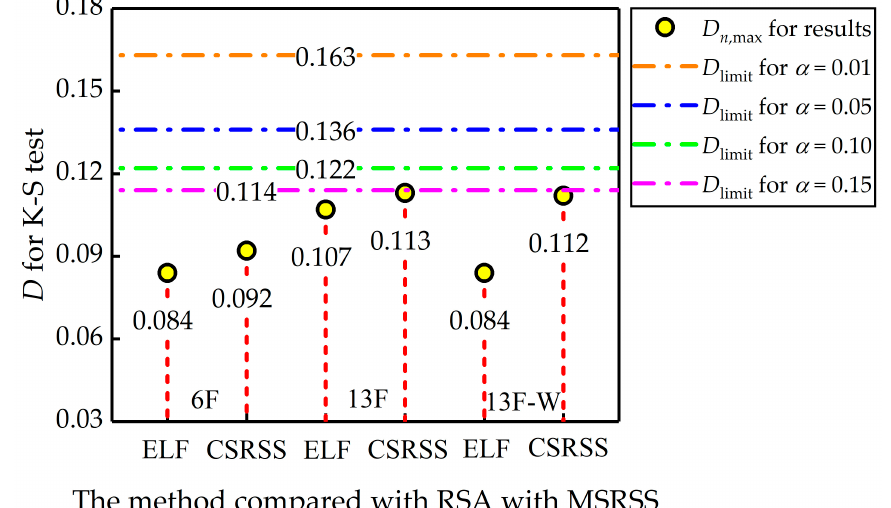
Figure 14. Error comparison between RSA-MSRSS with ELF and RSA-CSRSS.